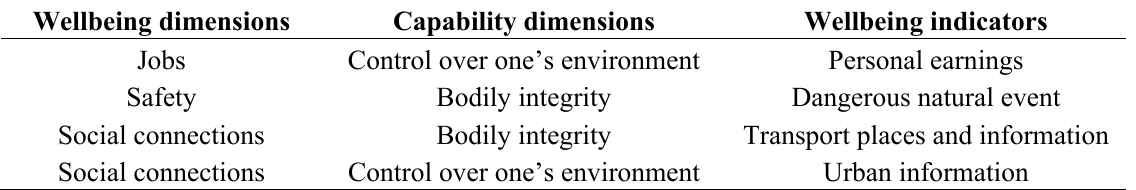
Table 3. Triples of wellbeing-capability dimensions and wellbeing indicators having no associated data set.